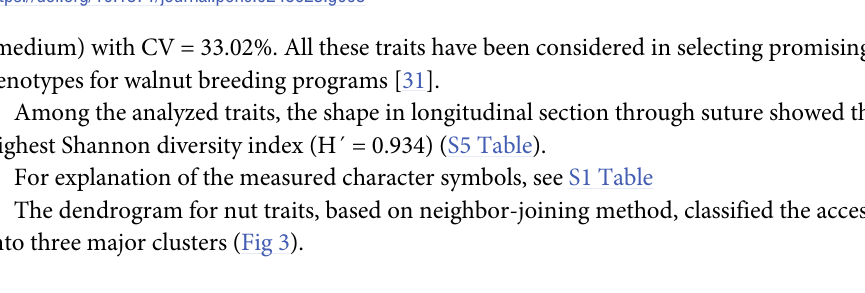
Fig 3. Genetic classification of J . regia accessions using the Neighbor-Joining method. The genotypes selected for a core collection are illustrated in red.